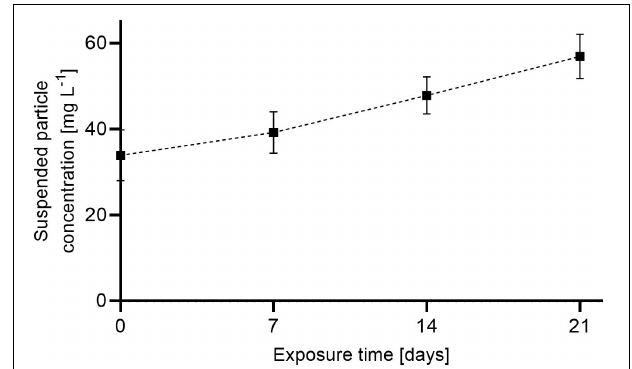
FIGURE 5 | Average of end concentrations ± SD of suspended sediment in exposure ( n = 5) and control tanks ( n = 5) throughout the experiment. Overall average exposure level was 44.9 ± 2.2 mg L − 1 . Suspended sediment concentration in the control tanks was assessed once in the beginning of the experiment (1.9 ± 0.8 mg L − 1 ).